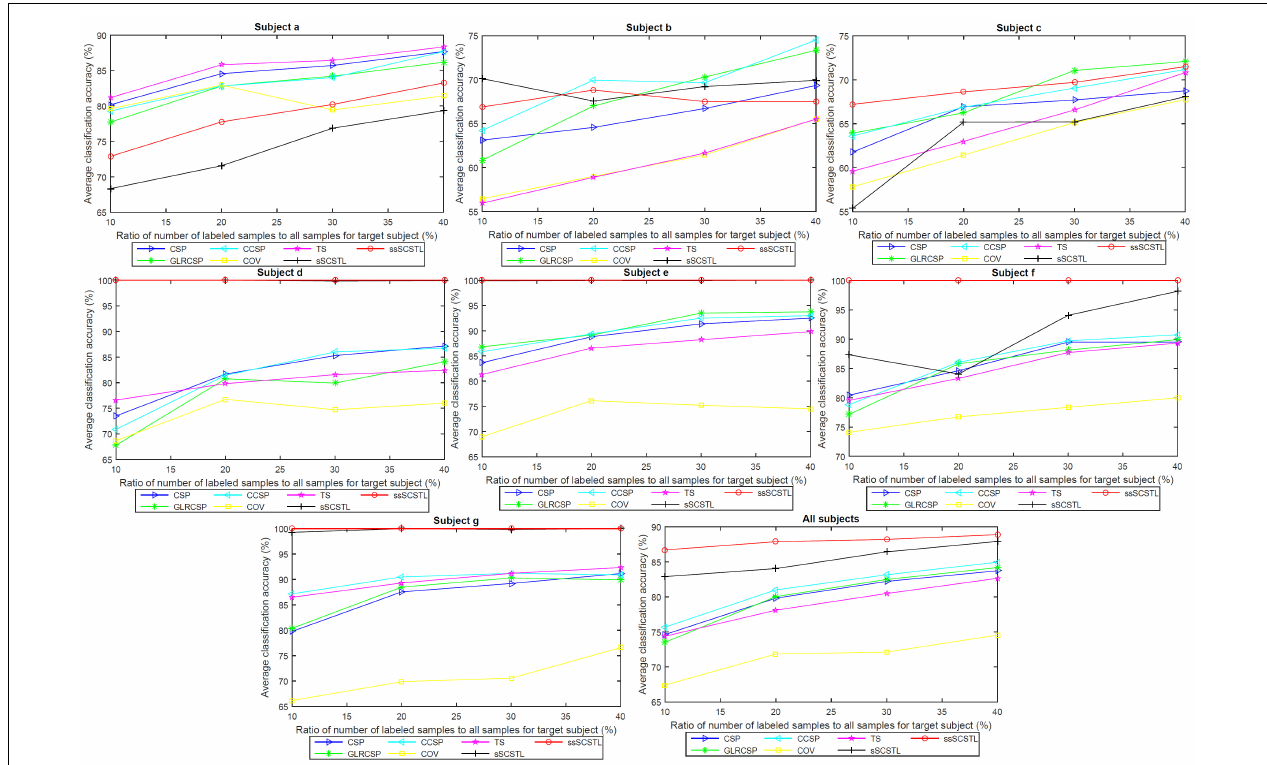
FIGURE 6 | Average classification accuracies of all subjects on dataset MI2, and their means, with varying R l , for supervised and semi-supervised algorithms.